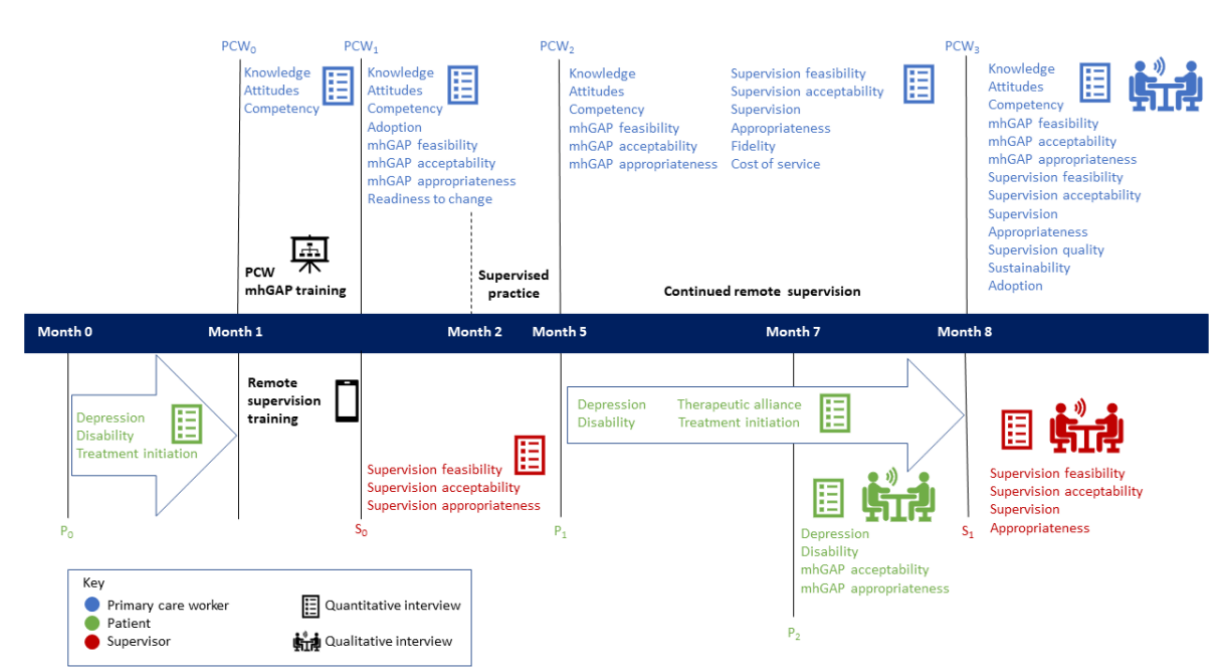
Figure 1. Feasibility study patient and provider data collection procedure. mhGAP: Mental Health Gap Action Programme; P 0 : patient pre